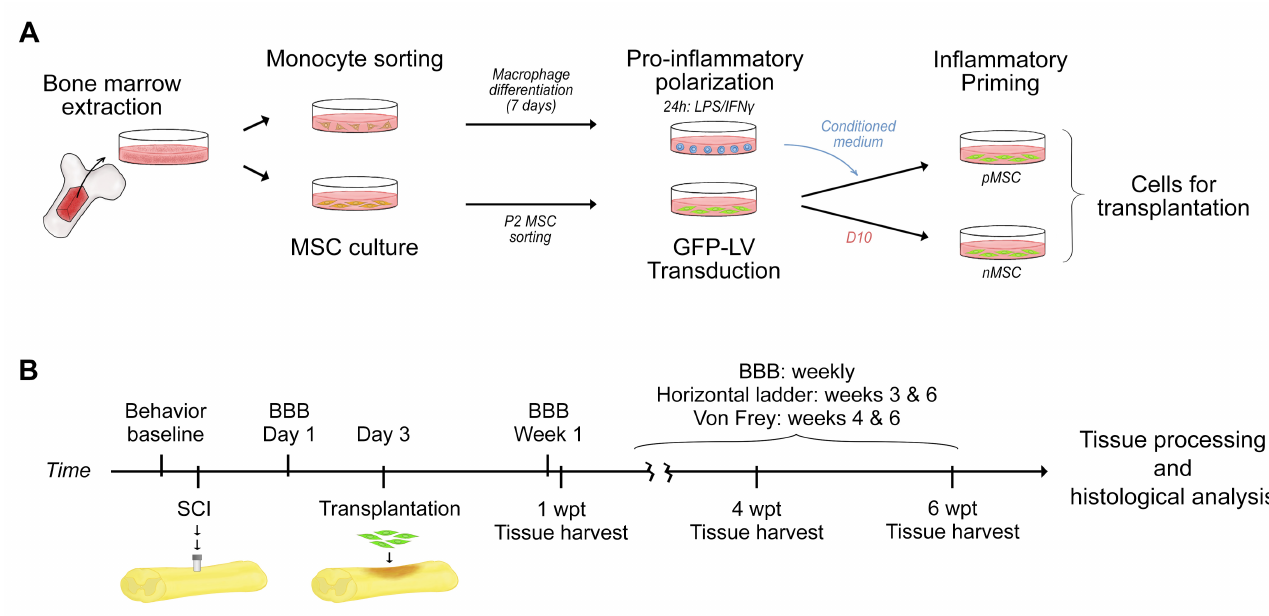
Figure 1. Experimental design. ( A ) The bone marrow was extracted from rats’ femurs and tibias and cultured on plastic dishes for 24 h. Then, monocytes were sorted using FACS and cultured for 7 days until differentiated to bone-marrow- derived macrophages. Mature macrophages were polarized to pro-inflammatory cells by culture in medium with LPS and IFN γ for 24 h. The conditioned medium (CM) from pro-inflammatory macrophages was collected and, later, used to prime MSC. In parallel, bone-marrow-derived MSC, adhered to the dish during the 24 h of bone marrow culture, were maintained in culture until passage 2, then FACS-sorted for purification. Sorted MSC were transduced with GFP-lentivirus to turn them green and trackable. P4 GFP-positive MSC were divided into two batches; one was cultured for 24 h in pro-inflammatory macrophage CM (primed MSC, pMSC) and the other one was cultured for 24 h in fresh D10 (naïve MSC, nMSC). pMSC and nMSC were trypsinized and resuspended in DMEM:F12 for transplantation. ( B ) Rats were acclimated to the behavioral tests before surgery, and the baseline scores for each test were obtained. Surgery for contusive SCI was performed. and the next day, BBB scores of the injured rats were collected. Three days after injury, surgery for direct injection of pMSC, nMSC, or DMEM:F12 was performed. At 1 and 4 wpt, six rats per group and time point were fixed and their spinal cords